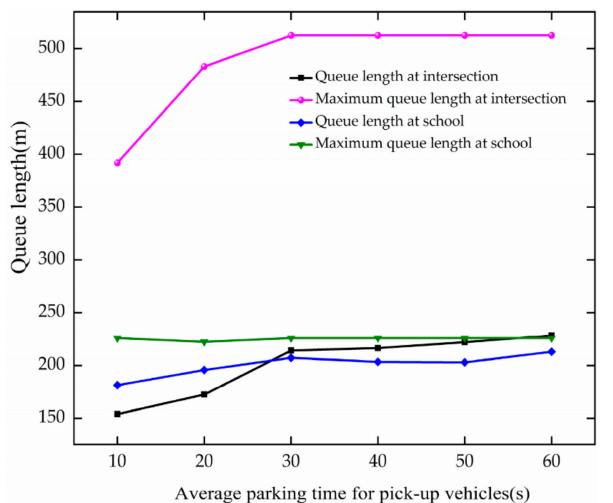
Figure 27. Variation trend of queue length with